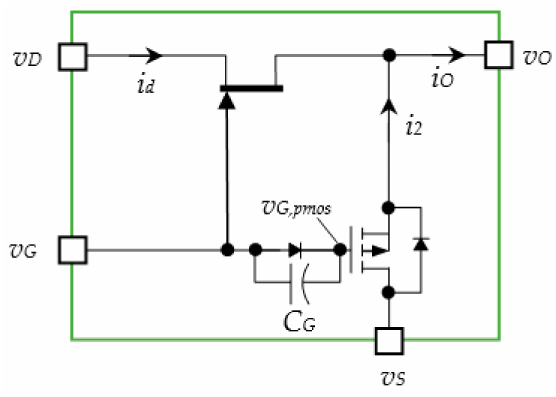
Figure 10. P-Cascode GaN HEMT